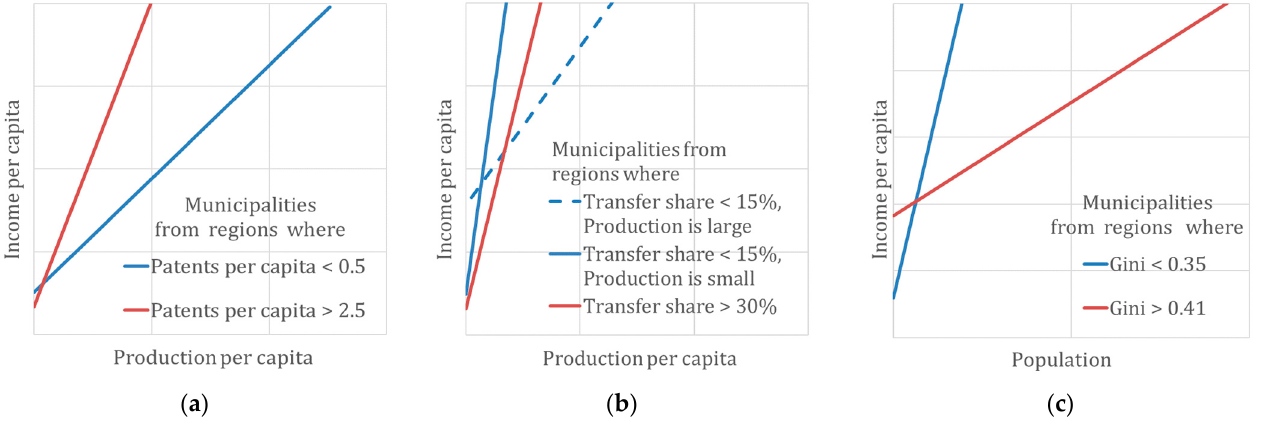
Figure 6. The relationships between population income and production volume at the municipal scale are under the influence of factors related to regional-level patents per capita ( a ) and transfer share ( b ). The relationships between population income and population size at the municipal scale are under influence of factors related to regional level Gini coefficient ( c ). The lines describing the relationship of indicators at the municipal level were built using the OLS method, not for all groups but only for several ones with the highest and lowest values of the indicators. The influence of other factors was not taken into account.